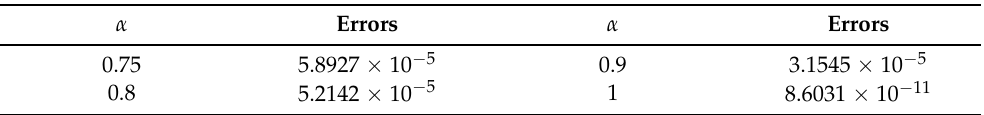
Table 1. The maximum absolute errors between the numerical solutions and the exact solutions in Equation (84) for different fractional order α